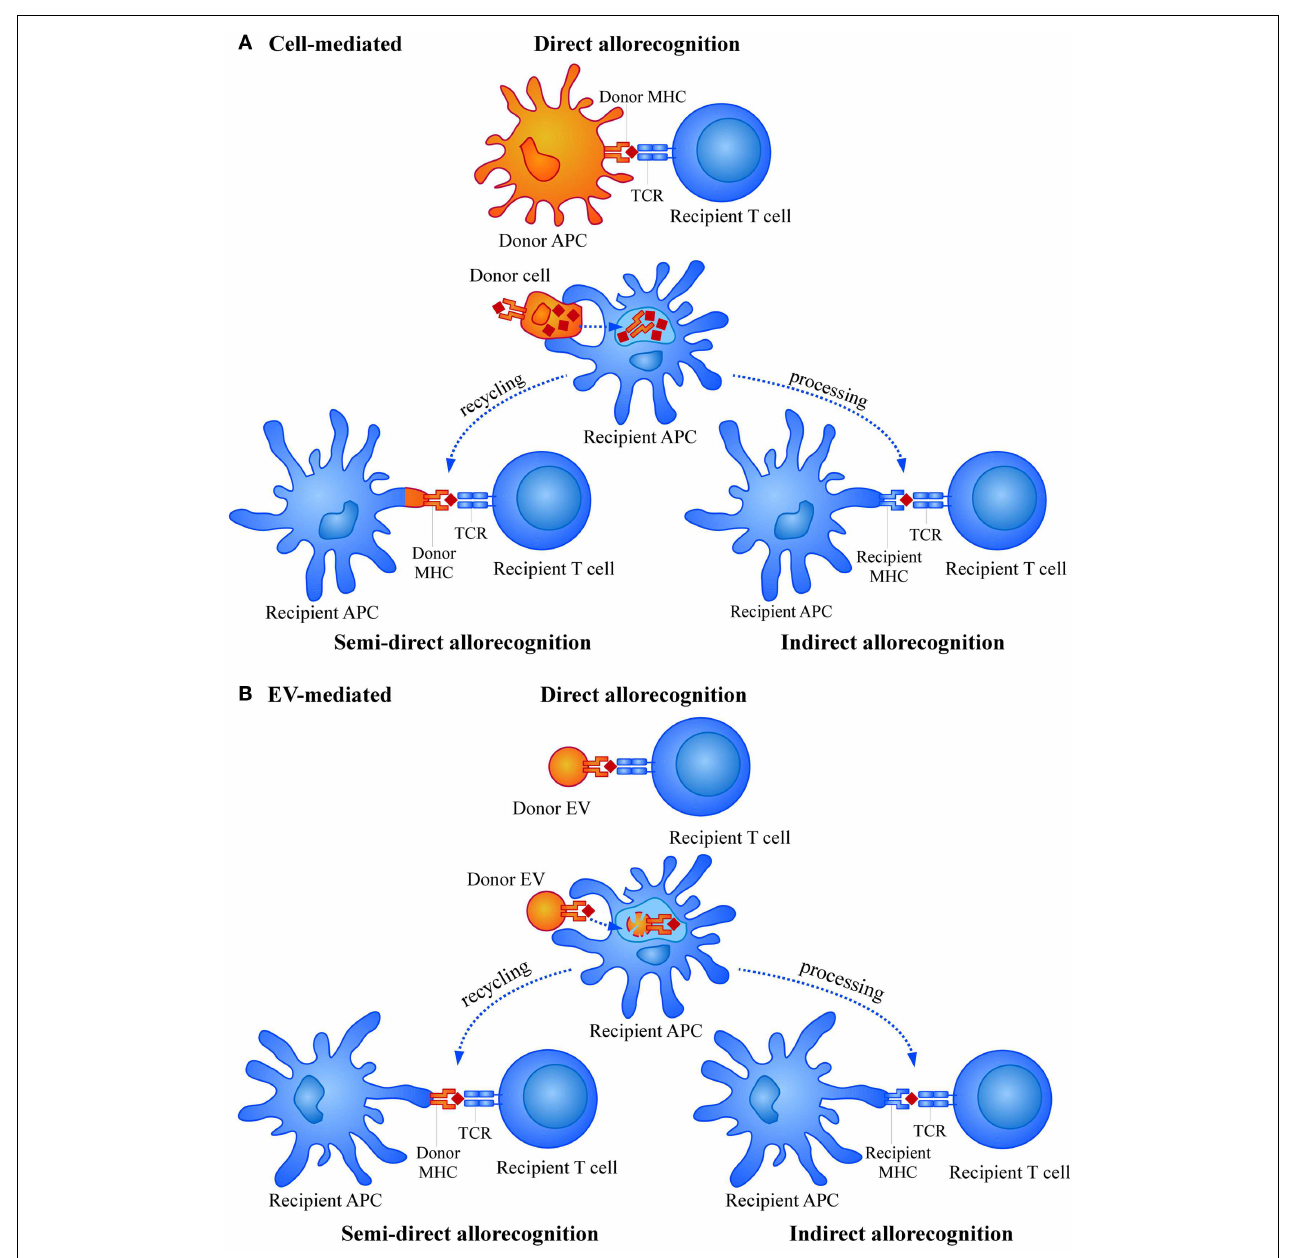
FIGURE 1 | Mechanisms of allorecognition by (A) cells and (B) extracellular vesicles (EVs)